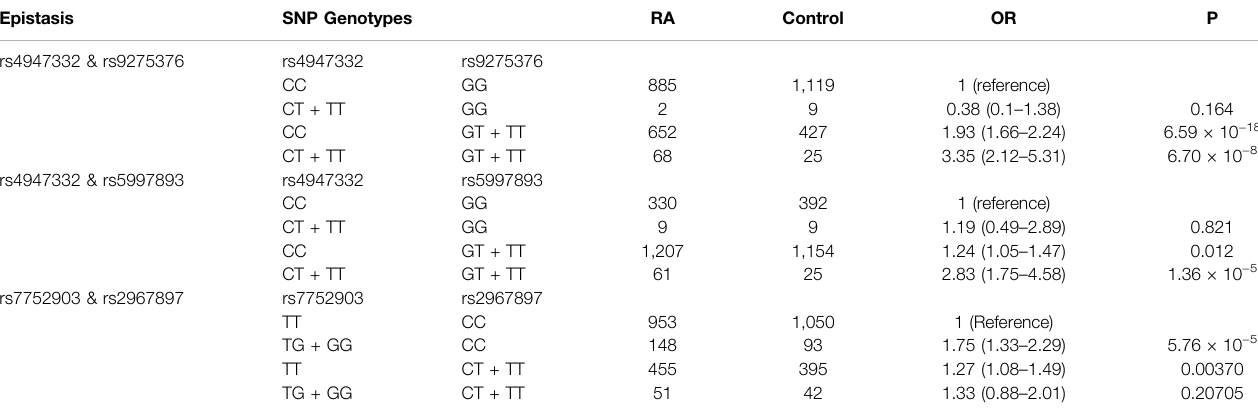
TABLE 4 | Epistasis analysis to identify SNP-SNP interaction in rheumatoid arthritis susceptibility.